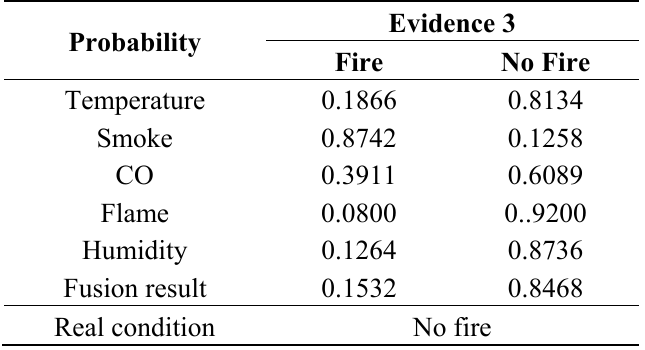
Table 4. Fire probability data and fusion result in Condition 3.